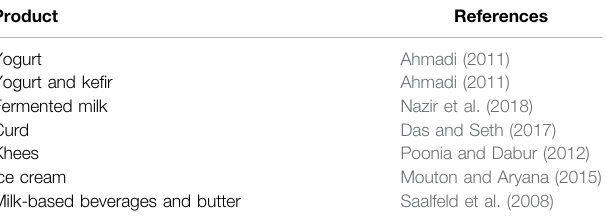
TABLE 1| Studiesevaluatingtheadditionofbovine colostrumindairyproduction.